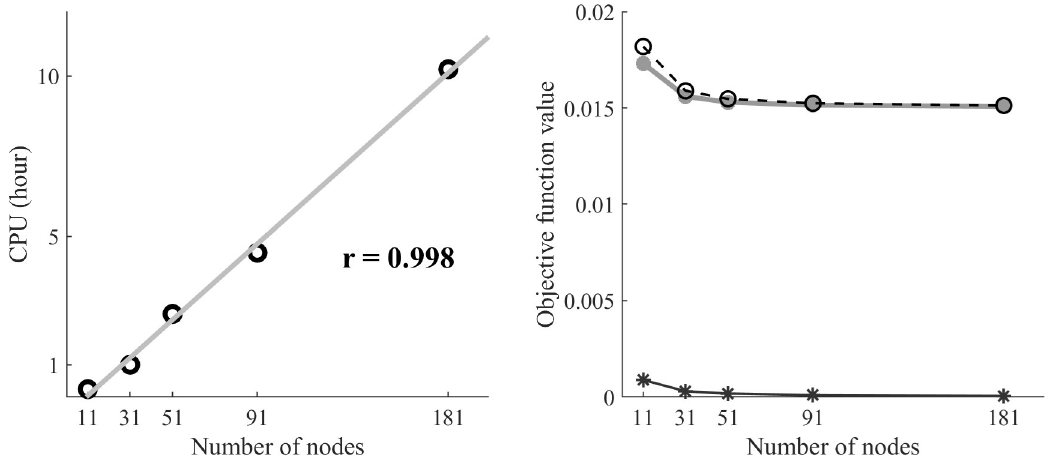
Fig 4. Effects of changing the number of nodes in the discretization on the CPU time and objective function value. (A) The CPU time increased almost linearly as a function of the number of nodes. (B) The total objective function value ( black dashed line ) decreased 12.7% from 11 to 31 nodes, with little further change above 31 nodes. The slight changes in the total objective function value were reflected in both the activation term ( dark gray solid line) and the tracking term ( light gray solid line ). Note that the tracking term can in principle go to zero (i.e. perfect tracking), while the activation term